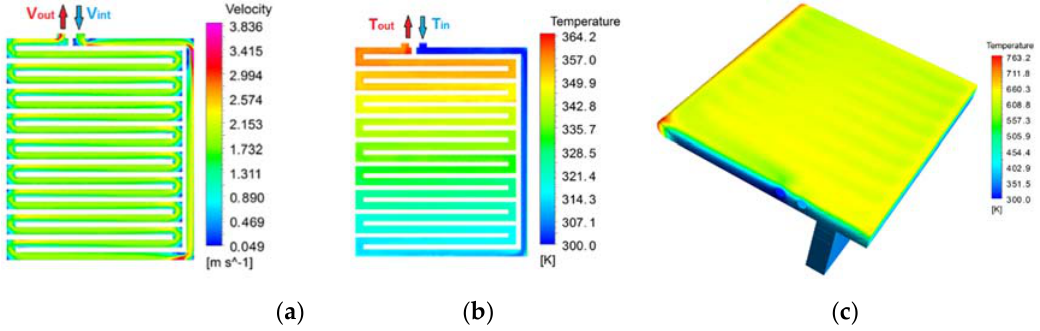
Figure 10. ( a ) Detailed model results: water speed; ( b ) cooling water temperature; ( c ) metal temperature. The main results for the original design (A) and for different proposed configurations (rounded NC and non ‐ rounded NR) are shown in Table 1 and Figure 11. Table 1. Port design comparison.